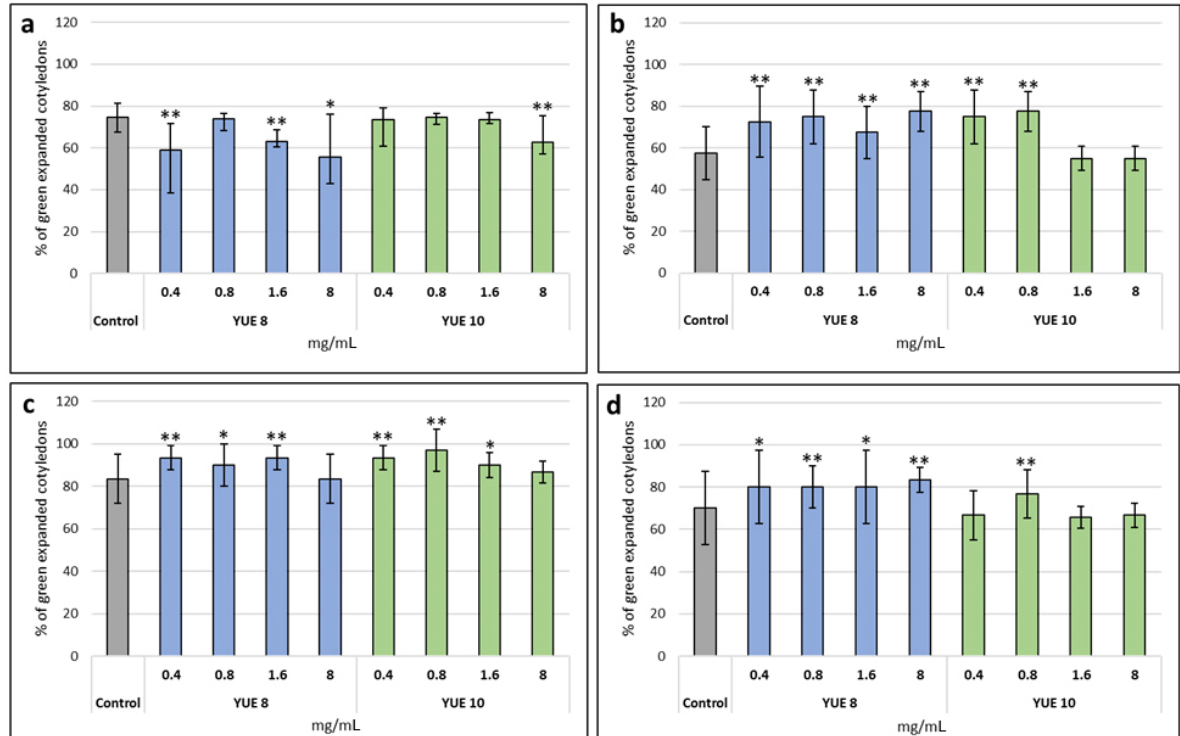
Figure 1. Determination of the effect of yucca extracts on the germination of ( a ) A. thaliana Col 0 WT, ( b ) broccoli, ( c ) tomato and ( d ) lettuce under normal conditions The X axis indicates the different concentrations (0.4, 0.8, 1.6 and 8 mg/mL) of the yucca extracts (control (gray); YUE 8 (blue) and YUE 10 (green)), while the Y axis represents the percentage of expanded green cotyledons. Statistical data from three experiments (n = 30 for each experiment) are presented. Bars represent the standard error * p < 0.05 by Student’s tests for increased germination compared to the control ** p < 0.01 by Student’s tests for increased germination compared to the control.